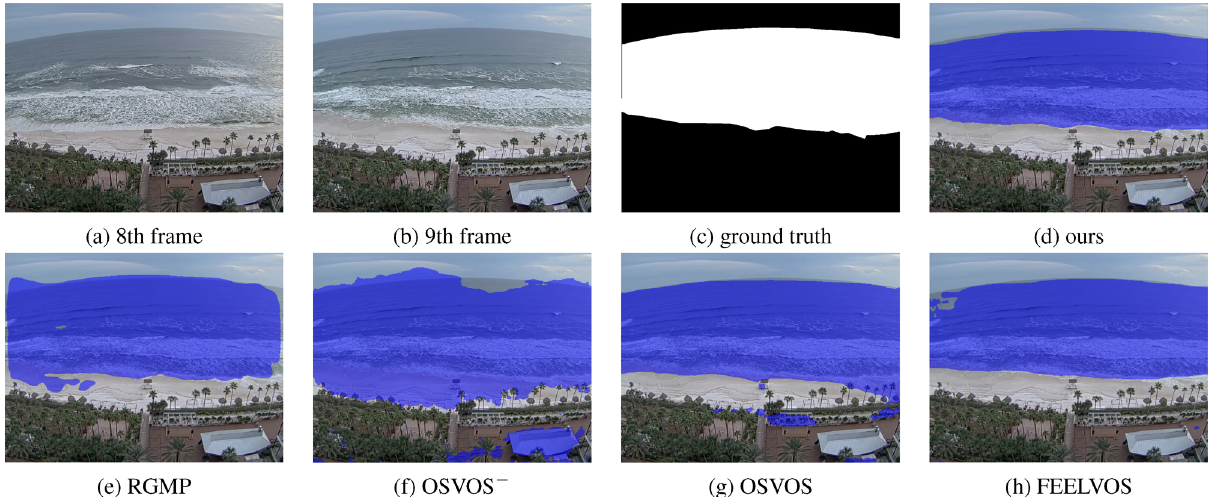
Fig. 9 Qualitative results from test video “Holiday Inn Beach”: (a) 8th frame, (b) 9th frame for segmentation, (c) ground-truth water, (d)–(h) segmentations of WaterNet, RGMP, OSVOS without online training, OSVOS, and